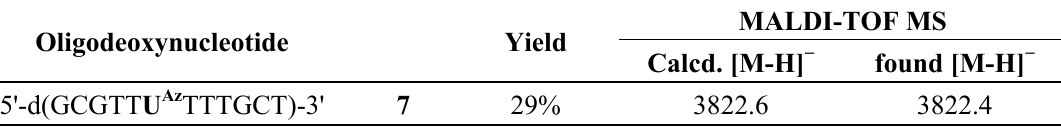
Table 4. Yields and MALDI-TOF MS data of dU Az -modified oligonucleotide. Oligodeoxynucleotide